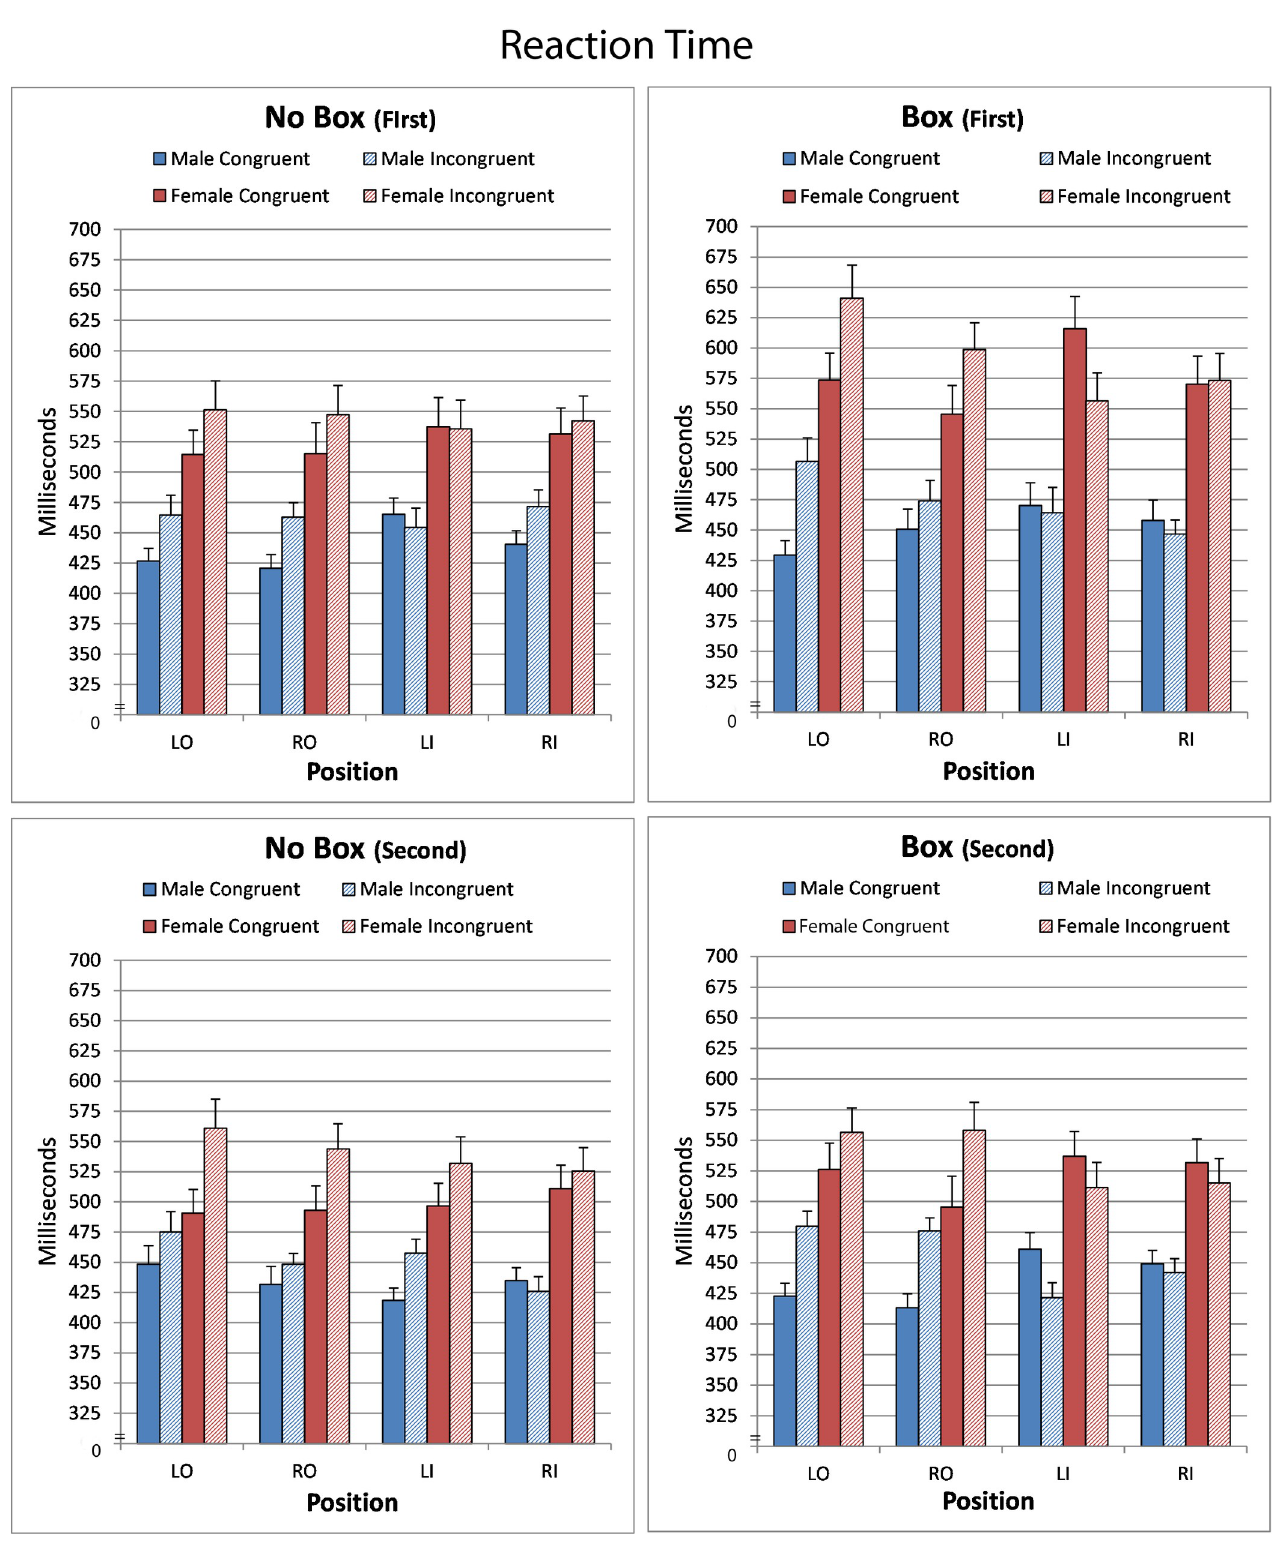
Fig 2. Depicted are reaction times (mean ± sem) for congruent and incongruent stimuli across condition, order of presentation and position. L = left; R = right; O = outer; I = inner. See results for statistical significance.